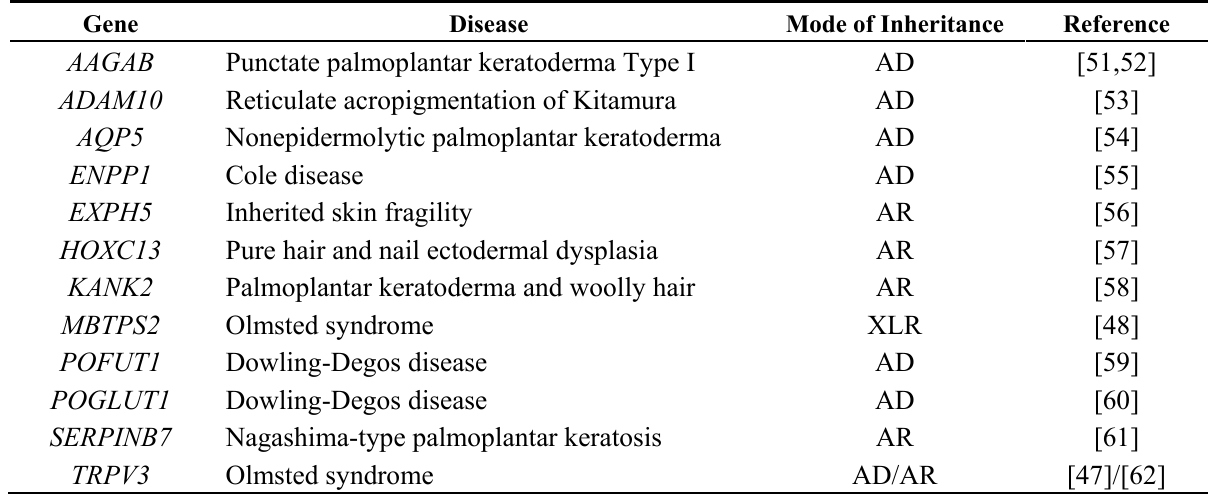
Table 1. Examples of genes associated with skin disease discovered using exome sequencing